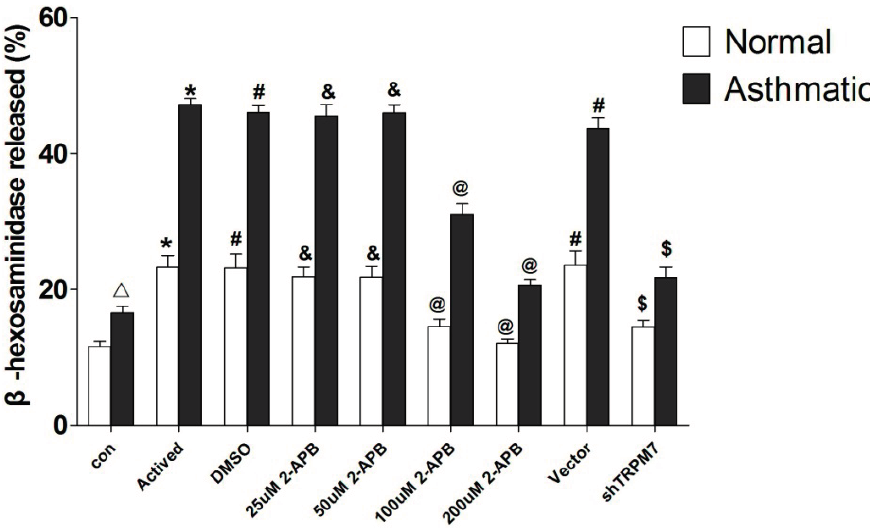
Figure 4. Levels of β -hexosaminidase activity in rat BMMCs. Δ compared to the normal group, the asthmatic group was significantly higher ( p < 0.05); * compared to the control group (con), the Activated group was significantly higher ( p < 0.05); # compared to the Activated group, the DMSO group and Vector group had no significant change ( p > 0.05); & compared to the Activated group, the 25 µM 2-APB group and 50 µM 2-APB group had no significant change ( p > 0.05); @ compared to Activated group, the 100 µM 2-APB group and 200 µM 2-APB group were significantly decreased ( p < 0.05); $ compared to the Vector group, the shRNA group was significantly decreased ( p <